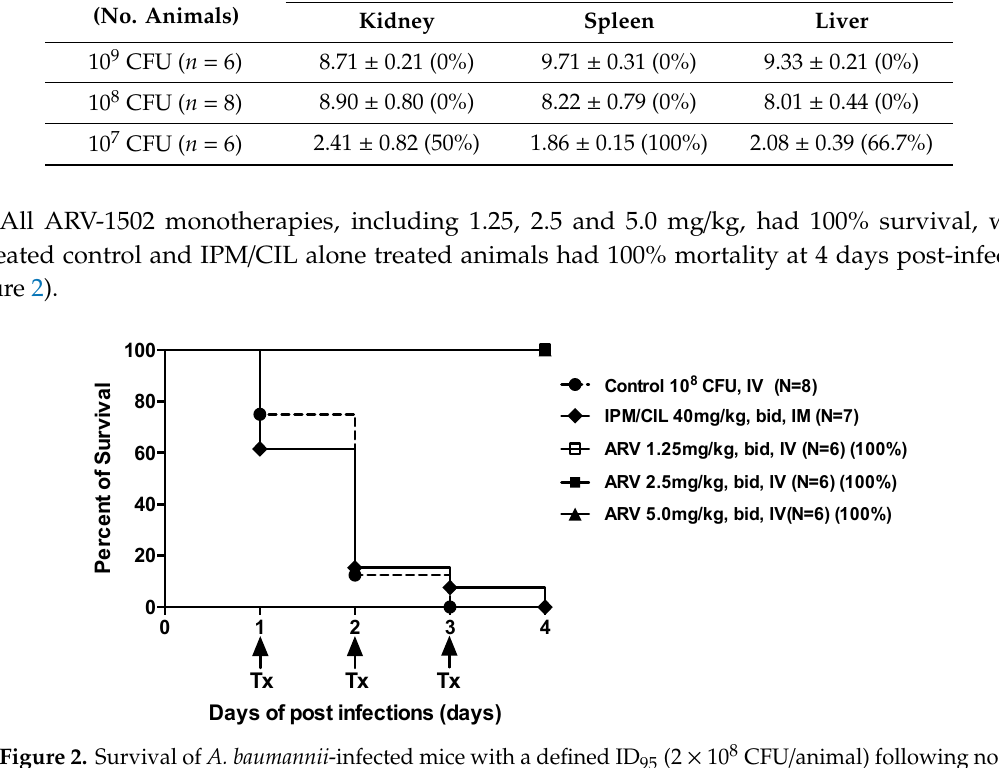
Figure 2. Survival of A. baumannii -infected mice with a defined ID 95 (2 × 10 8 CFU / animal) following no treatment (control), treatment with ARV-1502, imipenem / cilastatin (IPM / CIL) alone or in combination. Tx: treatment.